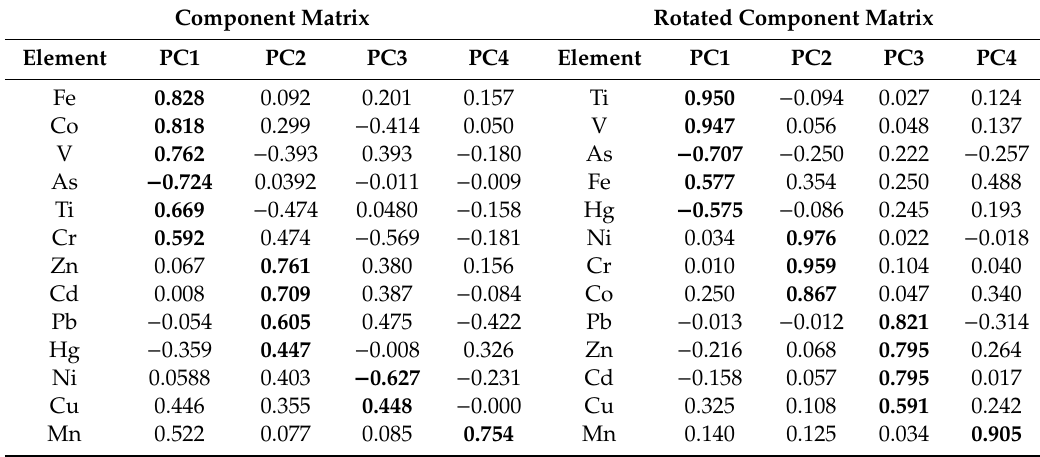
Table 4. Matrix of principal components analysis (significant loading factors are highlighted in